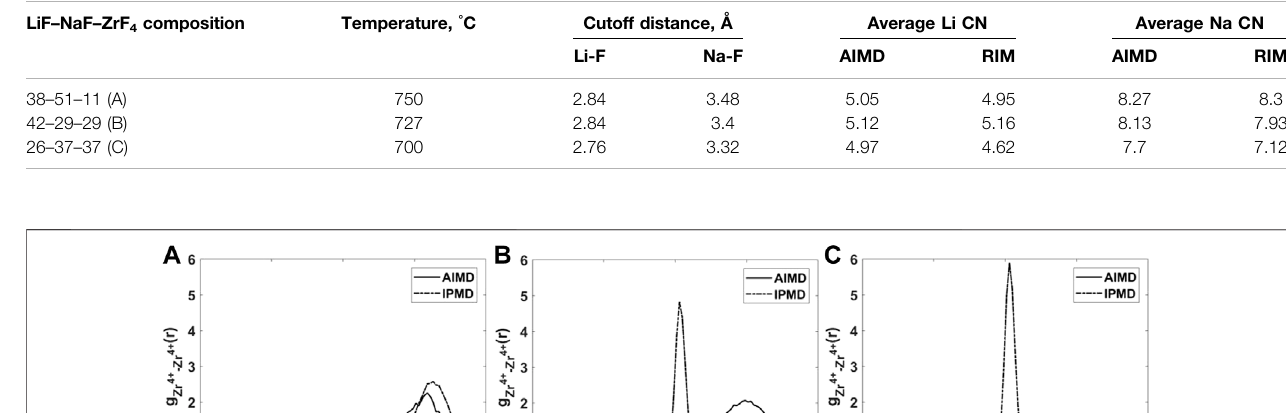
Frontiers in Physics |